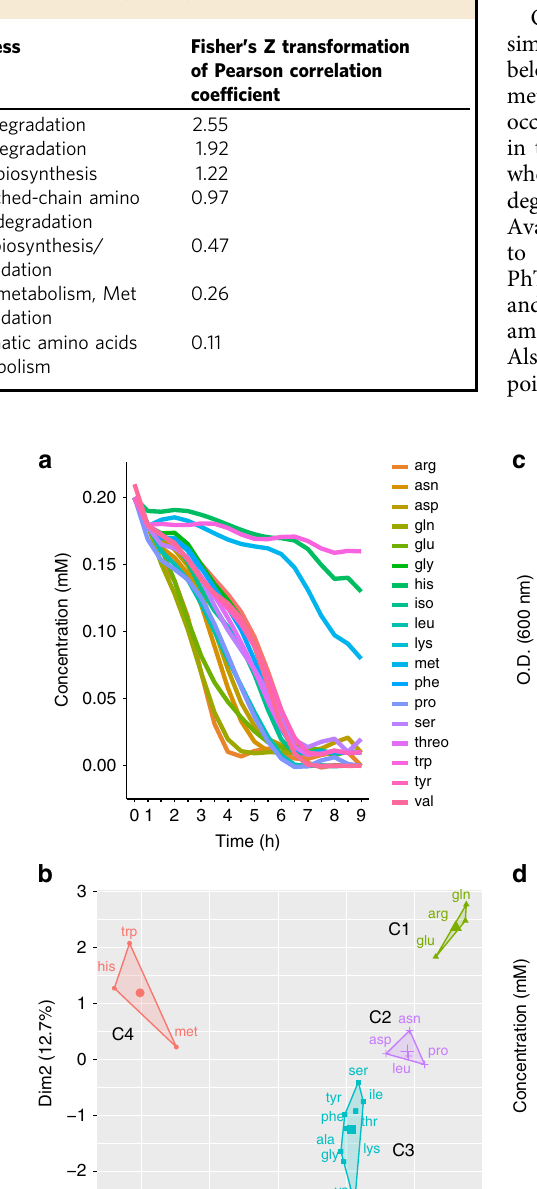
Table 1 Fisher ’ s Z transformation average of Pearson correlation of the same-regulon